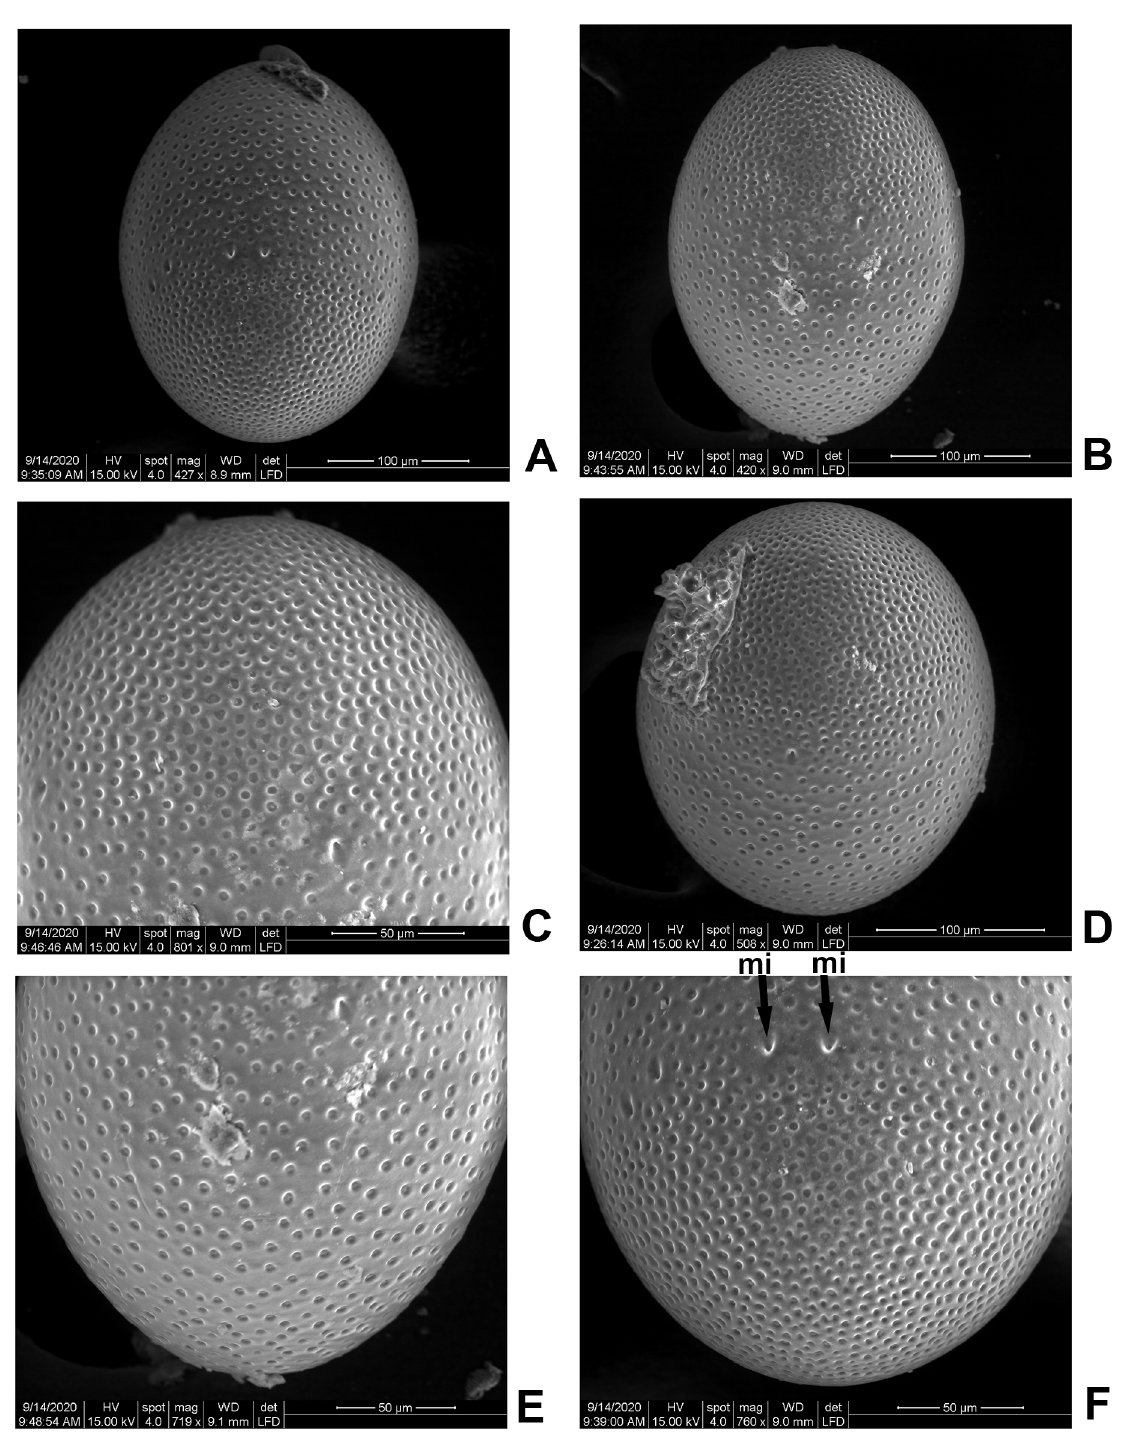
Fig. 5. Chinoperla changjiangensis sp. nov., eggs. A . Entire egg, lateral view. B . Entire egg, lateral view. C . Lid end, lateral view. D . Lid end, apical view. E . Collar end, lateral view. F . Micropyles (indicated by arrows). Abbreviations: see Material and